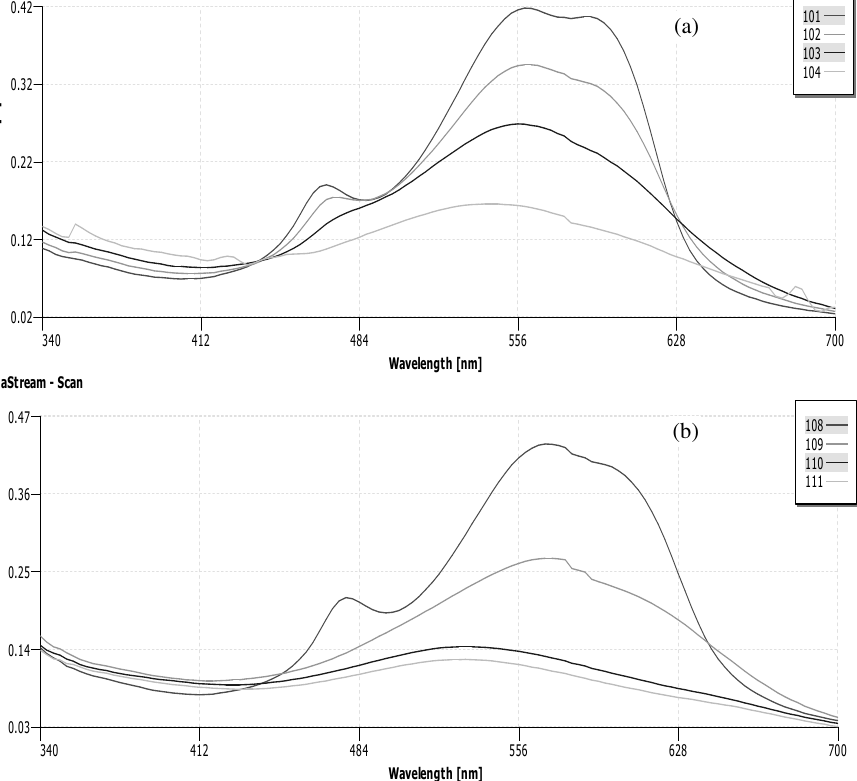
Figure 1. Absorption spectrum for the Resorcinol - Cresyl Violet -BrO 3− system with time. (a) in presence of 0.4 µ g/mL of Resorcinol (b) in absence of Resorcinol